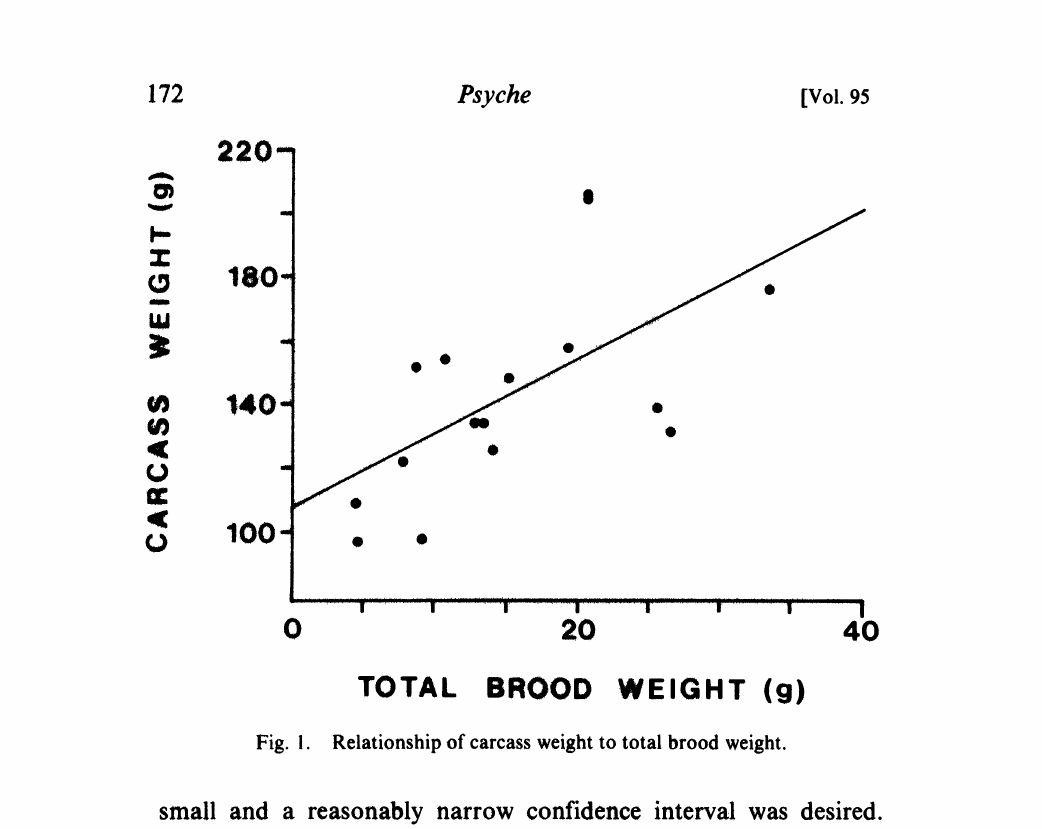
Fig. 1. Relationship of carcass weight to total brood